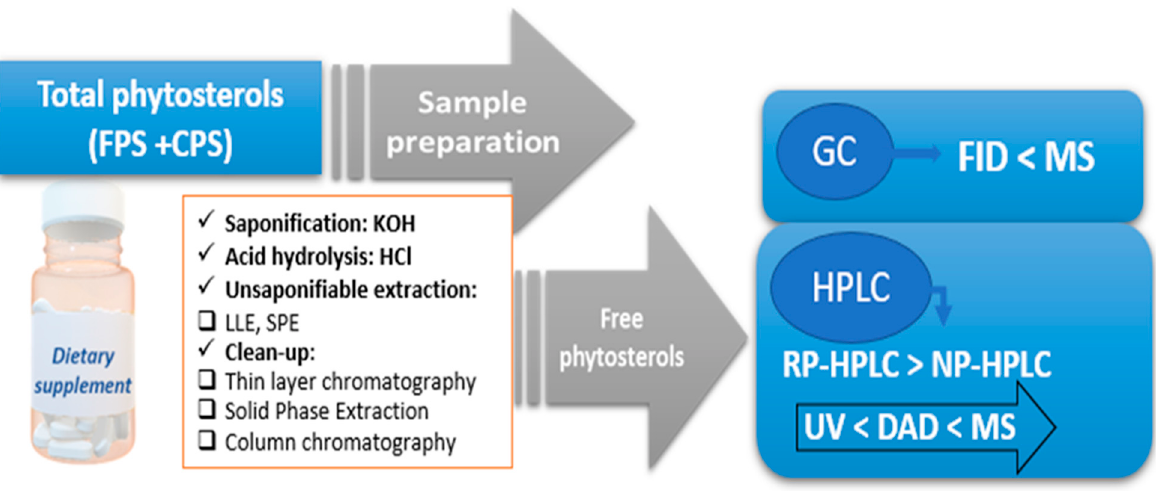
Figure 4. Main steps in the determination of total phytosterols. IS (internal standard) TMS (Trimethylsilyl ether); HPLC (high liquid chromatography); GC (gas chromatography); NP (normal phase); RP (reverse phase).